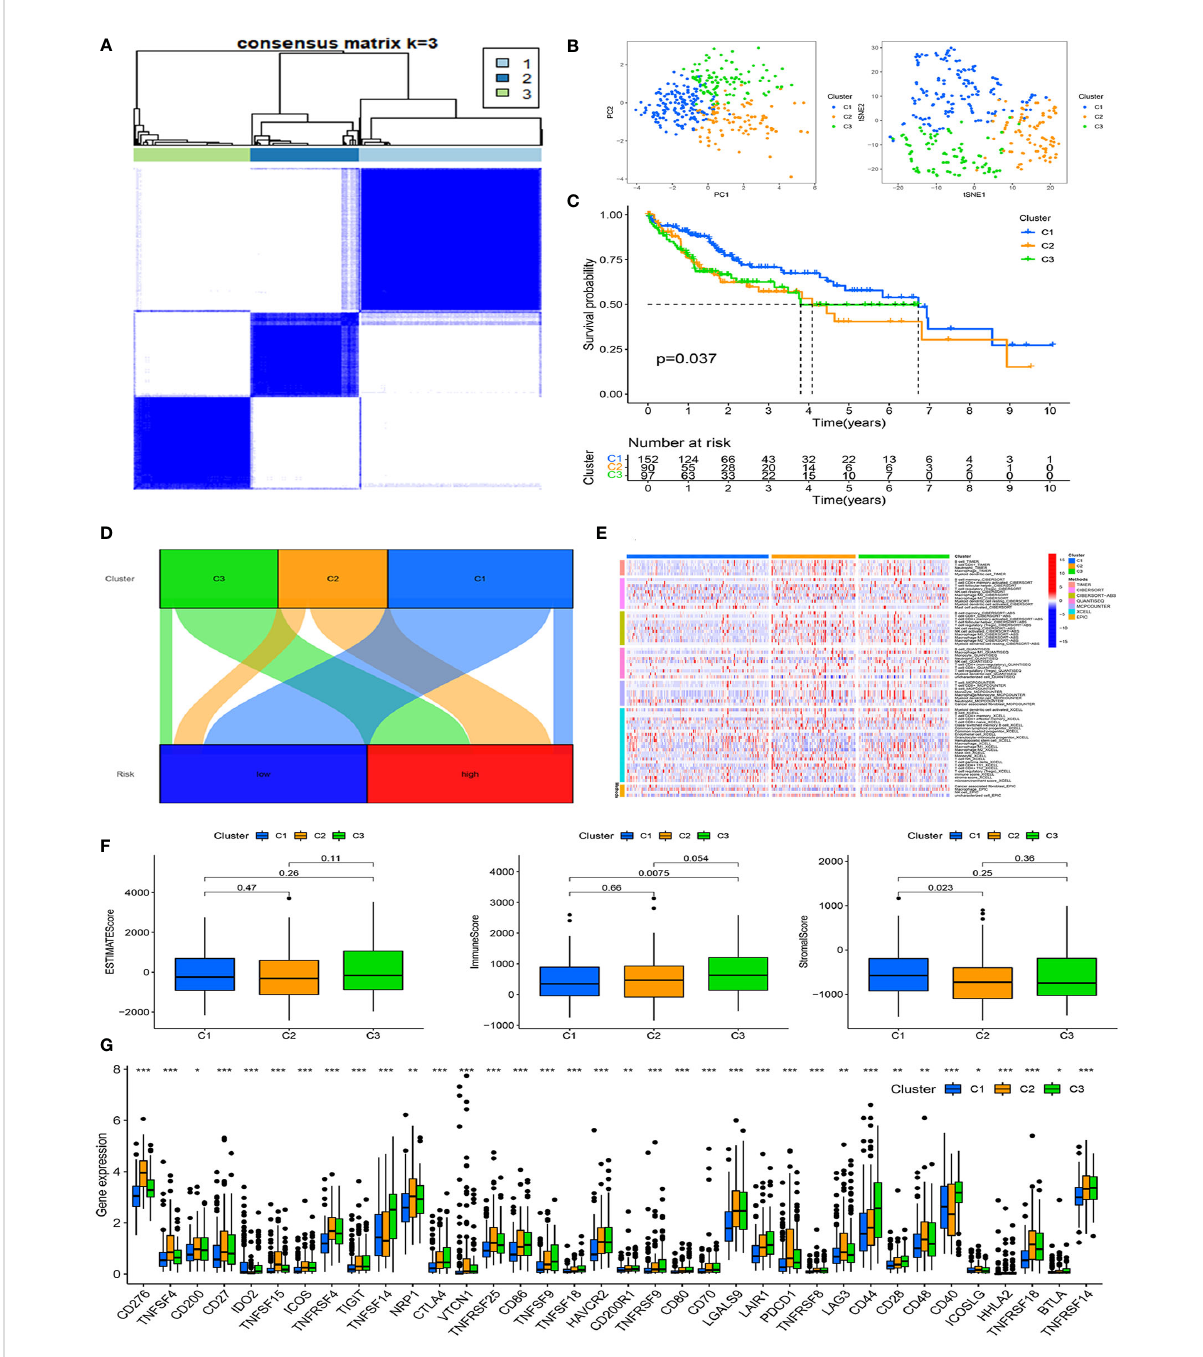
FIGURE 5 Consensus clustering analysis of the prognosis and immunity based on the mitochondria-related gene signature. (A) Identi fi cation of the optimal consensus matrix value. (B) The distribution of consensus clusters by PCA and tSNE analysis. (C) The prognosis of clusters C1, C2, and C3 by survival analysis. (D) The relationship between clusters and risk groups by alluvial diagram. (E) Analysis of the association between clusters and immune cells in different algorithms. (F) Analysis of the connection between clusters and ESTIMATE Score, Immune Score, and Stromal Score. (G) Analysis of the concern between clusters and immune checkpoints. *P<0.05, **P<0.01,